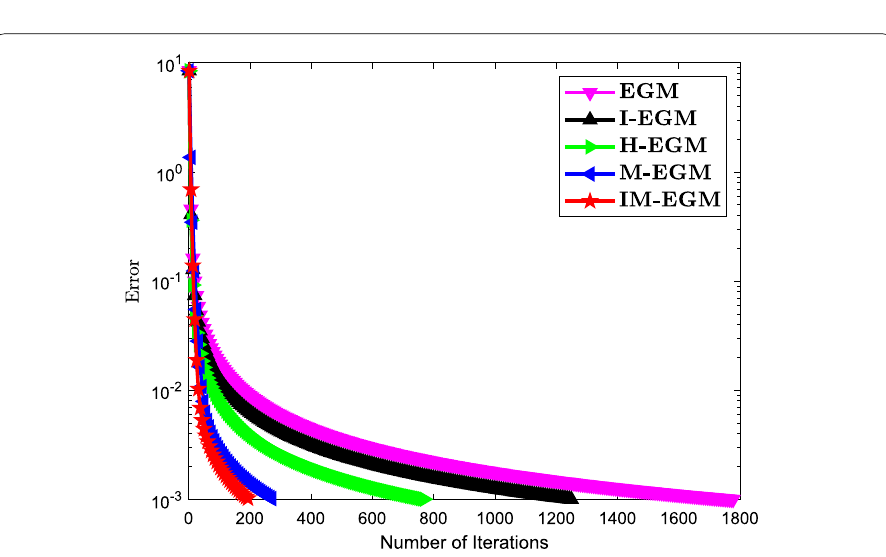
Figure 9 Numerical comparison of Algorithm 1 and Algorithm 2 using Algorithm 1 in [52], Algorithm 2 in [51], and Algorithm 1 in [18], while N = 50 for the error term 10